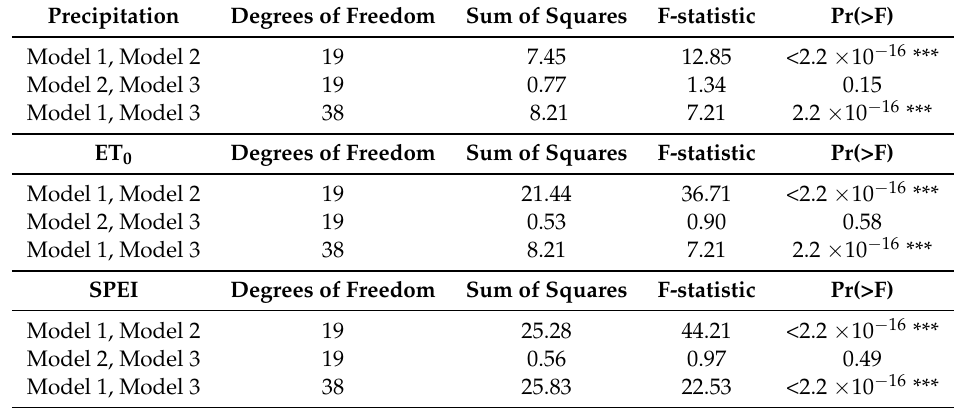
Table A1. Different p -values are used to determine significance. *** represent estimates that have p -values smaller than 0.001.